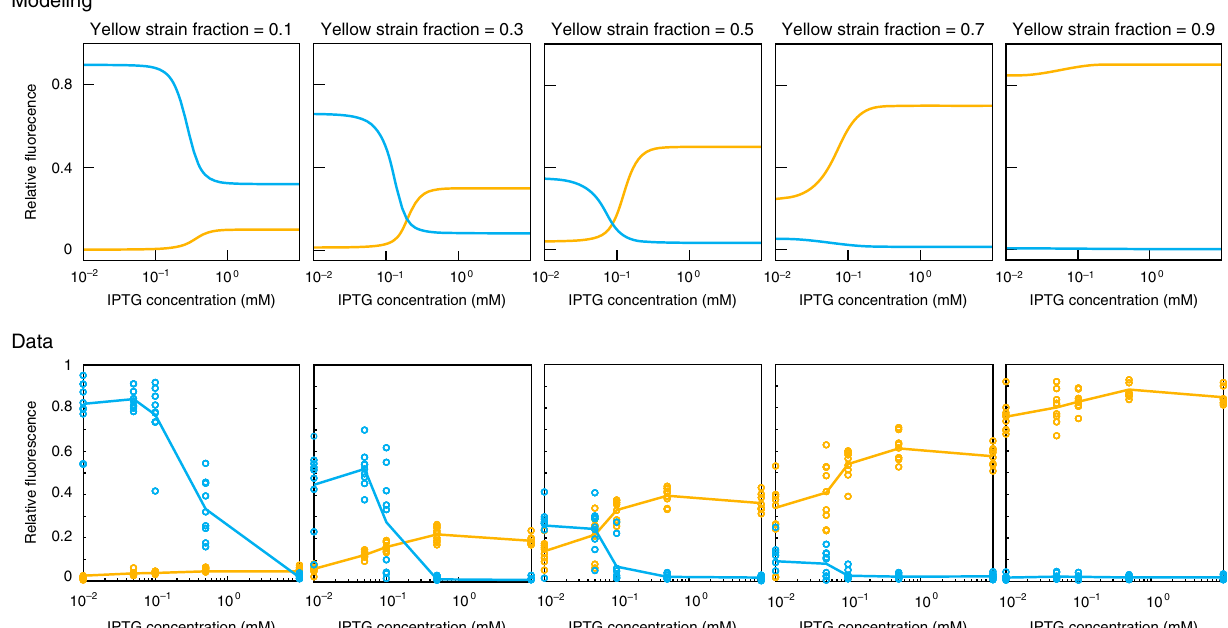
Fig. 4 Modeling strain ratio and inducer effect on fl uorescence. The top row of graphs present relative fl uorescence of the yellow and cyan strains as a function of normalized inducer concentration at set strain ratios from the mathematical model. The bottom row of graphs present relative fl uorescence of the yellow and cyan strains as a function of IPTG concentration at set strain ratios from the same experimental data presented in Fig. 3. To compare fl uorescence intensities, all fl uorescences are normalized to the values measured in wells containing a single strain (wells containing either 100% of the yellow strain or 100% of the cyan strain). Circles represent replicate experiments and lines represent averages across all replicates. The model agrees qualitatively with experimental results across all strain